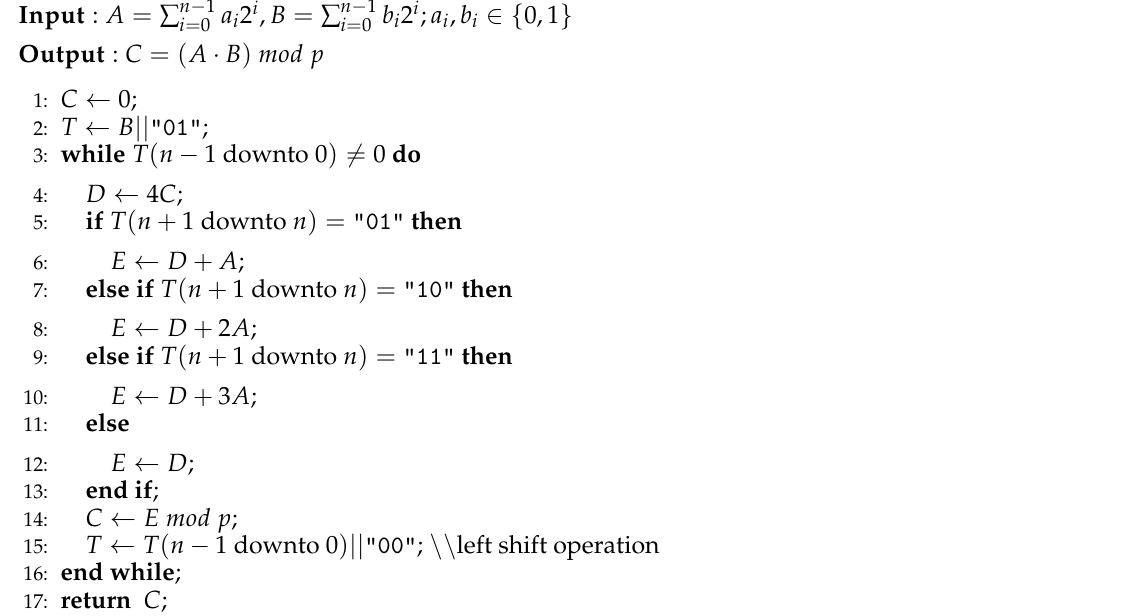
Algorithm 1 Proposed Radix-4 Interleaved Modular